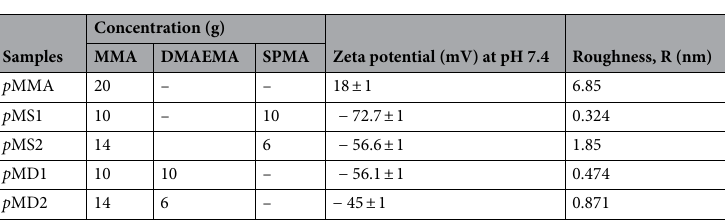
Table 2. Concentration of monomers in amphiphilic copolymers, zeta potential (mV), roughness (nm) and BSA adsorption capacity (%).